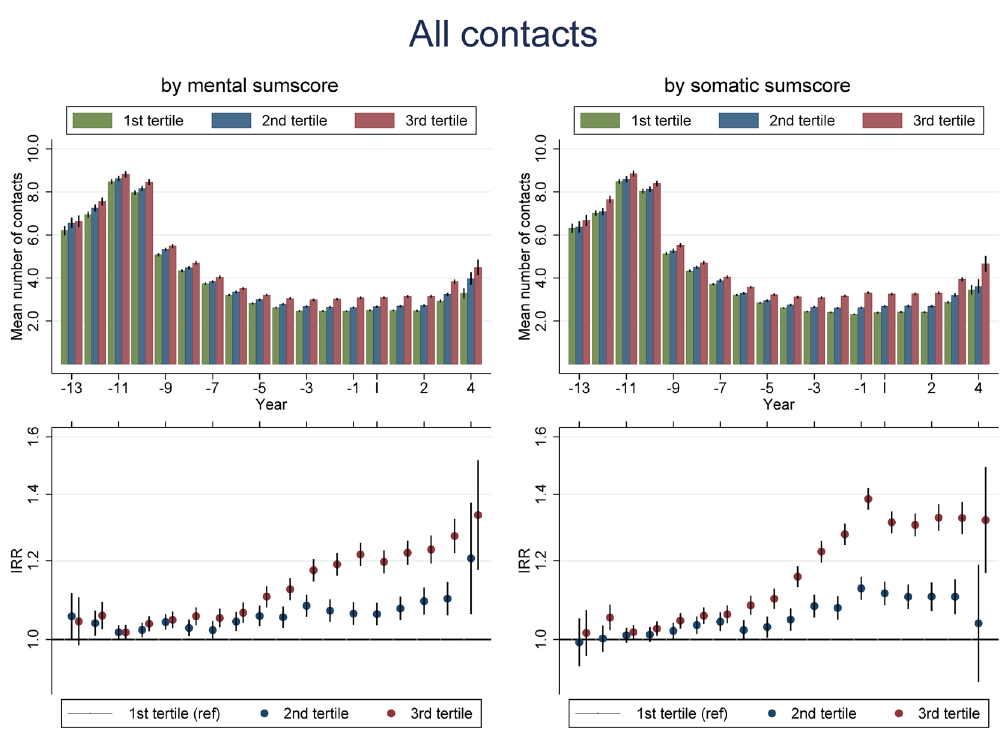
Figure 2. Mean number of yearly GP contacts by years before/since filling out the 11-year questionnaire according to burden of somatic (left panel) and mental (right panel) health complaints in top-panel and adjusted IRR (95%-CI) in bottom panel. The burden of somatic and mental health complaints was calculated as sum-scores depending on the frequency of symptoms reported and categorized into tertiles. IRRs and 95% CIs were estimated using negative binomial regression. Adjusted for sex, age, year, number of siblings, income and parental